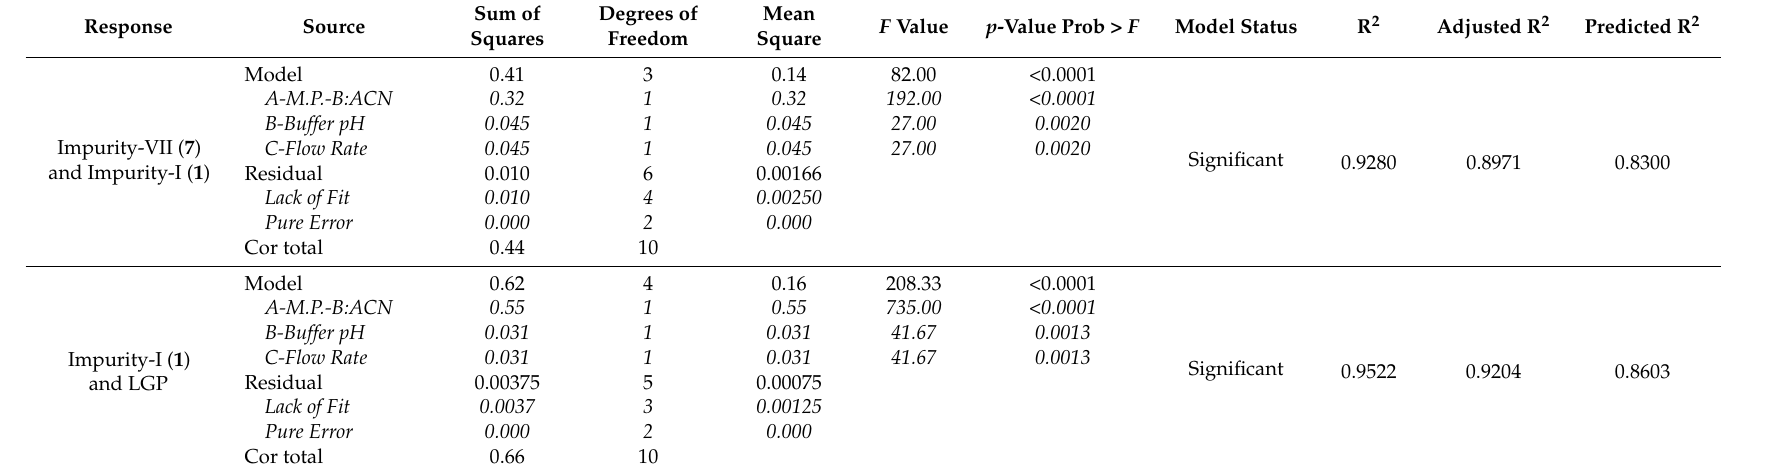
Table 1. ANOVA analysis for selected factorial model-used for prediction and diagnostic plots (Partial sum of